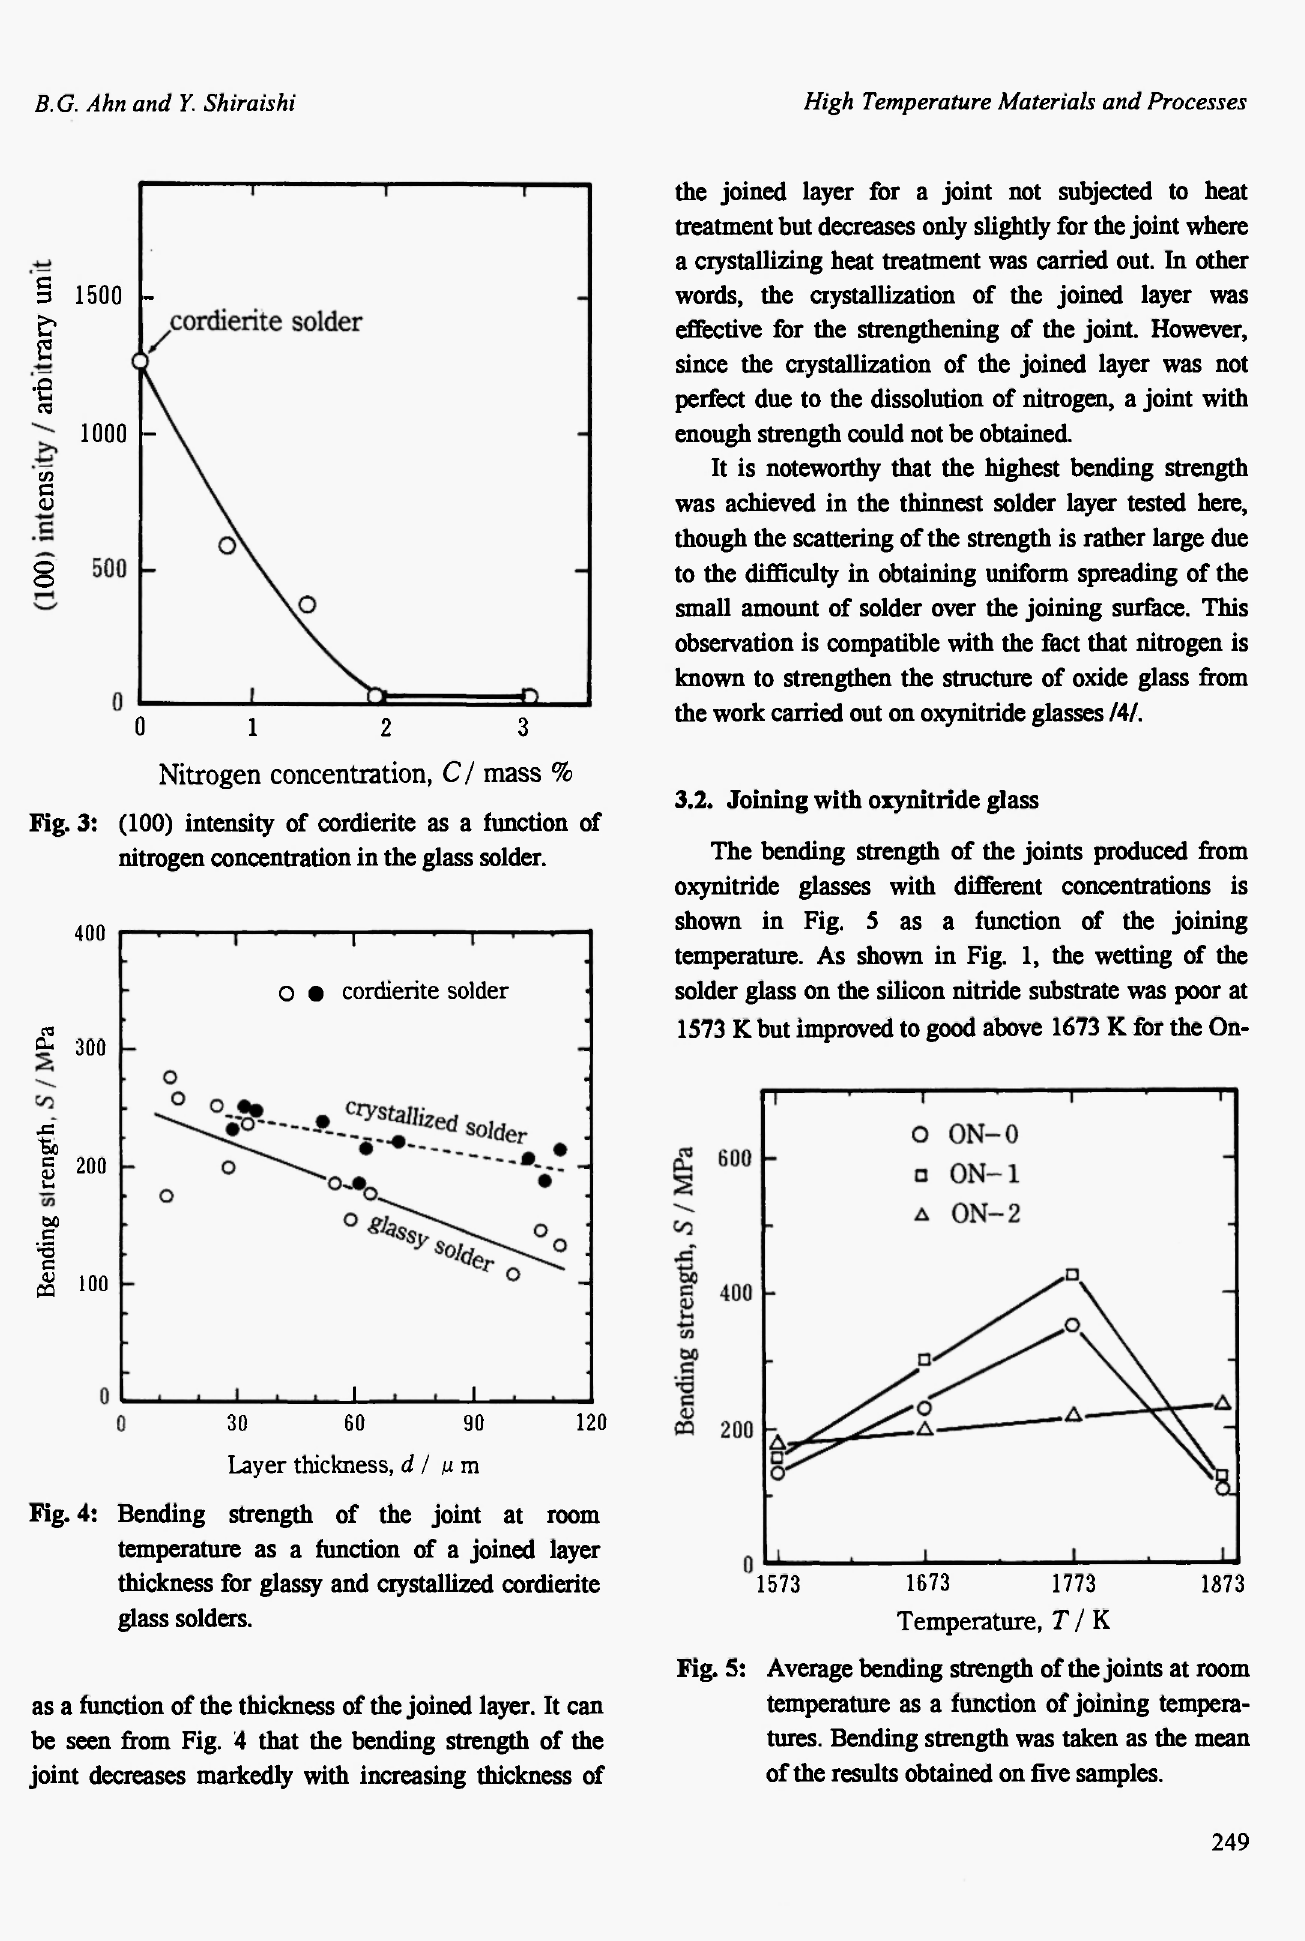
Fig. 4: Bending strength of the joint at room temperature as a function of a joined layer thickness for glassy and crystallized cordierite glass solders.